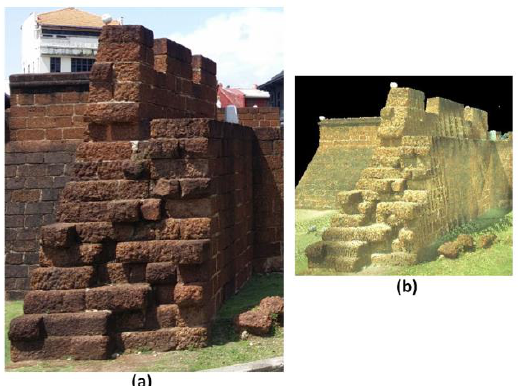
Figure 9. Simple comparison analysis between the real object (a), and the coloured point cloud data